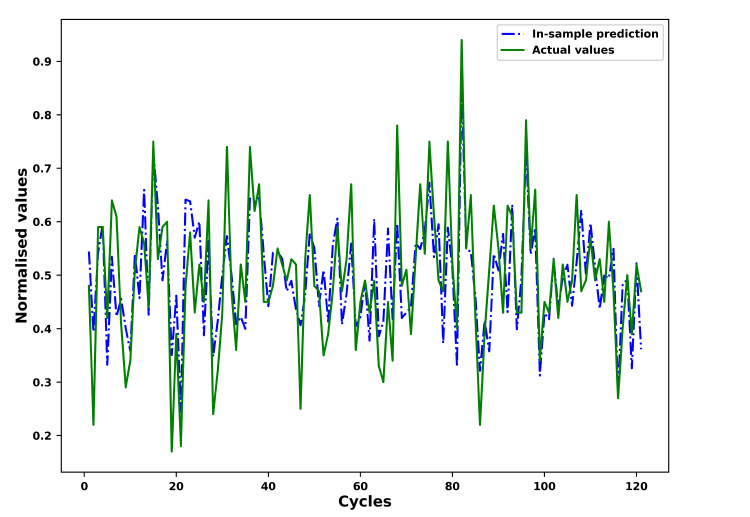
Figure 7. In-sample fitting of the first operational conditions of the unit 37 in FD001 test sets based on the FGM(1, 1) and ARIMA/ARMA calibration.